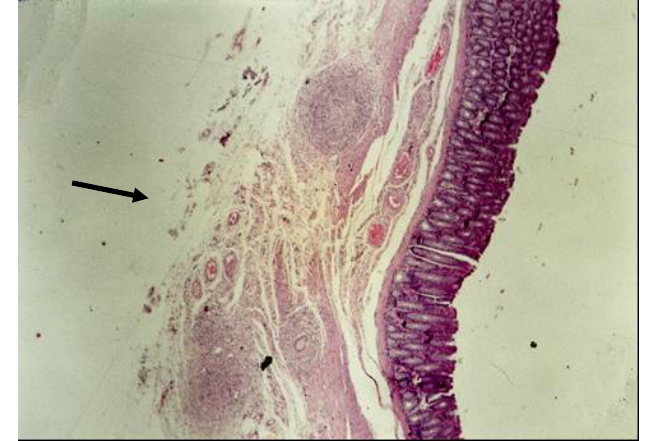
FIGURE 4 – Muscular layer interruption with the presence of giant cell reaction to foreign body at serosa. Hematoxilin and Eosin color. 4 X